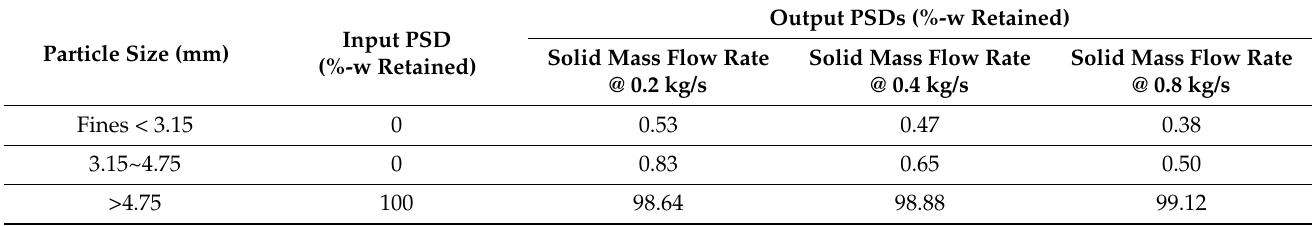
Table 4. Degradation of fresh pellets at 0.24 kg/s air flow rate with bends in proximity.